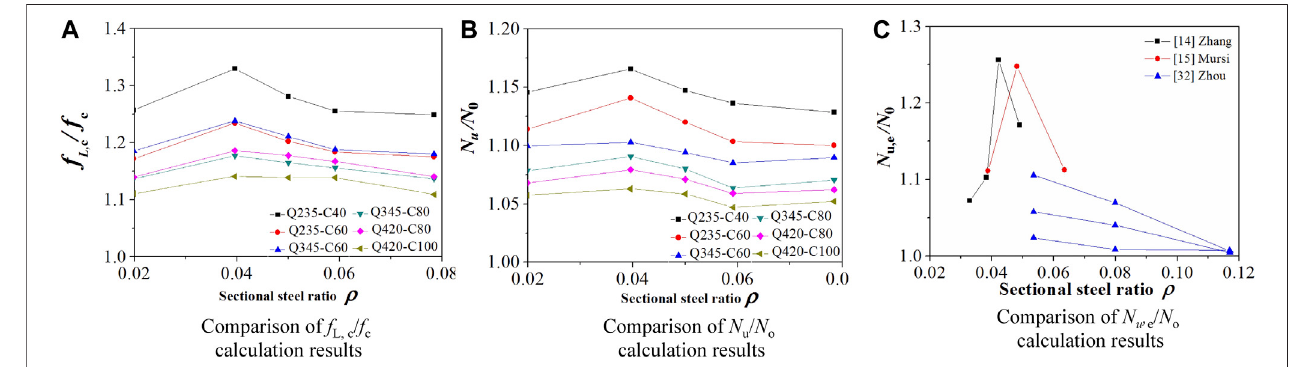
FIGURE 7 | Comparison of ratio of calculation results to theoretical values.